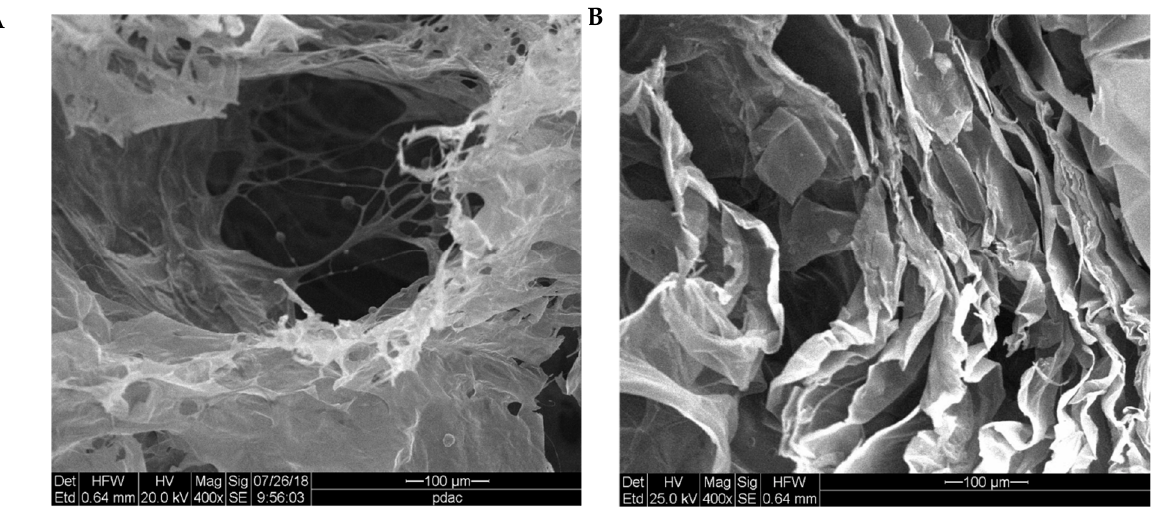
Figure 4. Secondary scanning electron microscopy (SEM) imaging of i -Pd(OAc) 2 (TPPTS) 2 : ( A ) Before reaction; ( B ) After 24 h of reaction.